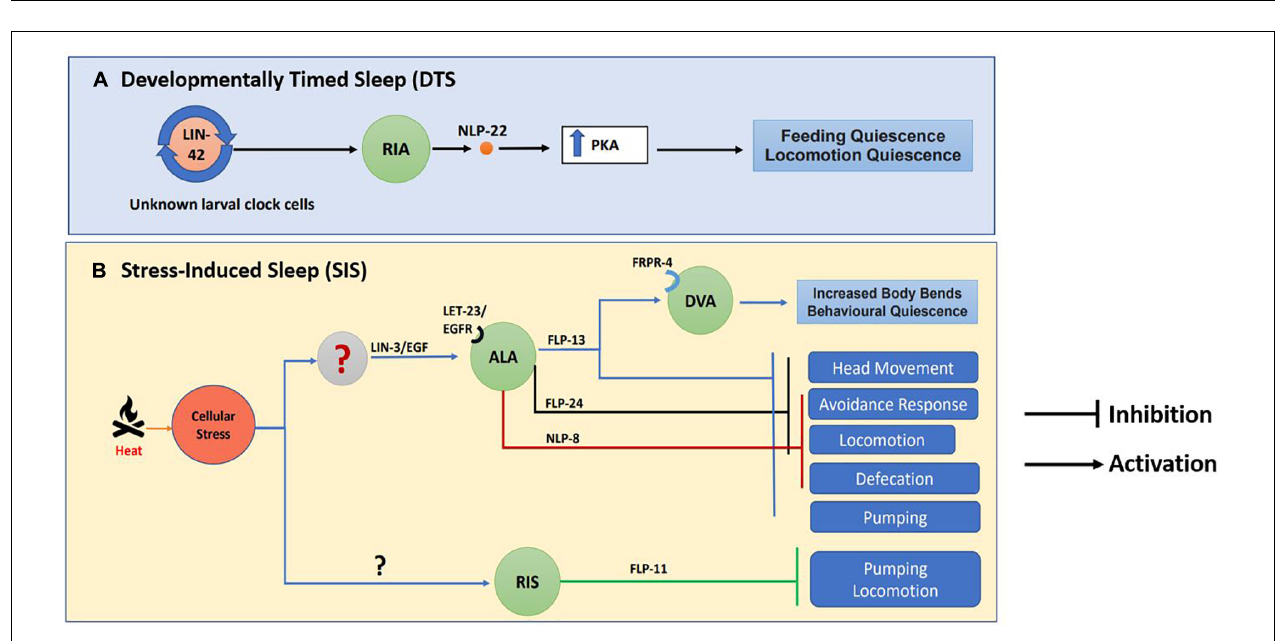
FIGURE 6 | Sleep patterns in C. elegans. The top panel shows the types of Sleep in C. elegans . The bottom Panel shows the physiological events during each type of sleep. The bottom panel has been adapted from Nath et al. (2016).